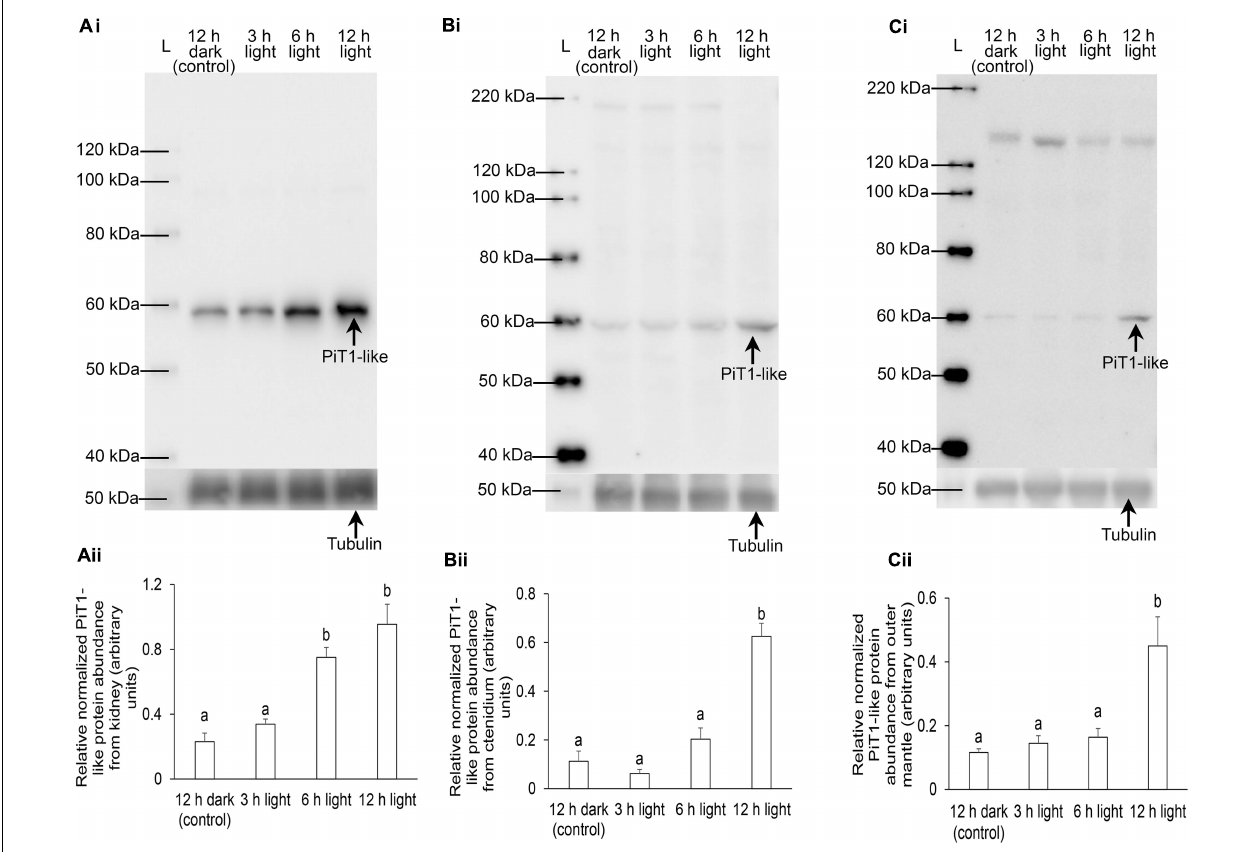
FIGURE 8 | Protein abundance of a homolog of sodium-dependent phosphate transporter protein 1 from the (A) kidney, (B) ctenidium, and (C) outer mantle of Tridacna squamosa kept in darkness for 12 h (control) or exposed to light for 3, 6, or 12 h. (i) A representative blot. L represents ladder. (ii) The optical density of the PiT1-like band for 20, 50, and 100 µ g of protein from kidney, ctenidium, and outer mantle, respectively, was expressed as arbitrary units and normalized with respect to that of tubulin from each tissue. Results represent means + SEM ( n = 4). Means not sharing the same letter are significantly different ( p -value <